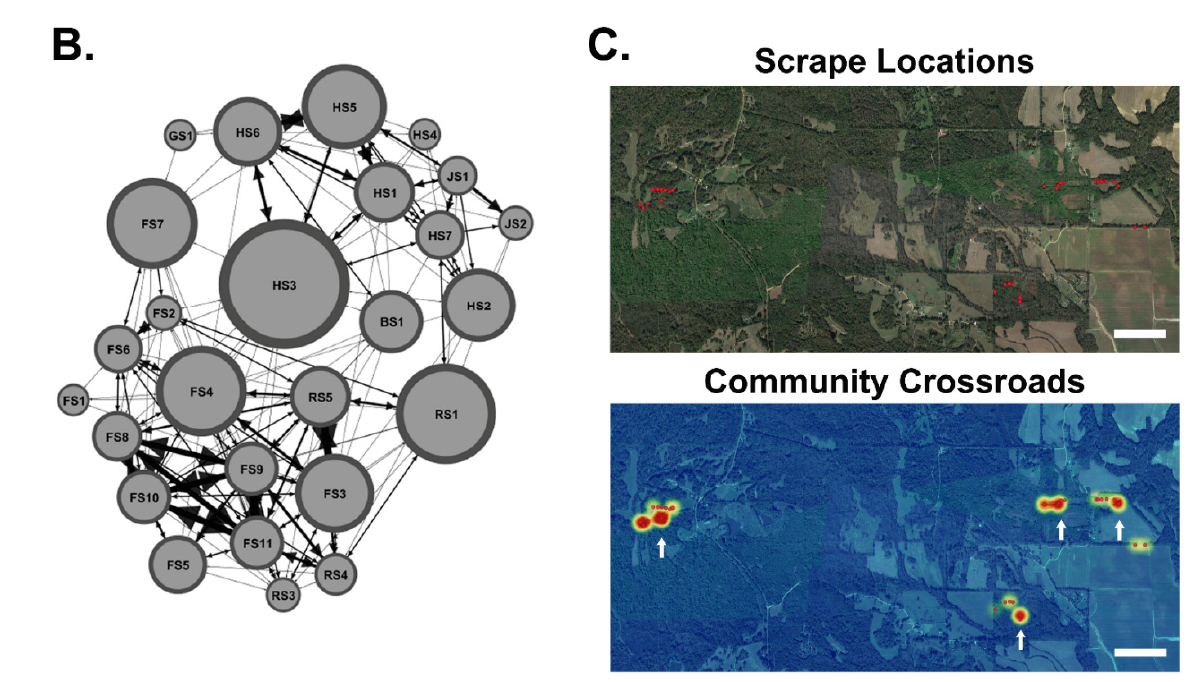
Figure 8. Disease Transmission Hotspots and Community Crossroads. ( A ) Shown is the base map of the scrape locations within Major Sites 1, 2, and 3. Scale bar: 0.5 miles. Shown are overlaid heatmaps of the number of unique males scraping at each scrape, scraping activity at each scrape, scrape weighted degree, and transmission hotspots located using our hotspot formula and our alternative hotspot formula. White arrows point to transmission hotspots (outliers found using the Z-scores). Scale bar: 0.5 miles. ( B ) Shown is the scrape-to-scrape network graph generated using scrapes as nodes and common males as edges. The node size reflects betweenness centrality scores. ( C ) Shown is a map of the scrape locations within Sites 1, 2, and 3. Shown is a heatmap of betweenness centrality scores highlighting community crossroads. White arrows point to community crossroads. Scale Bar: 0.5